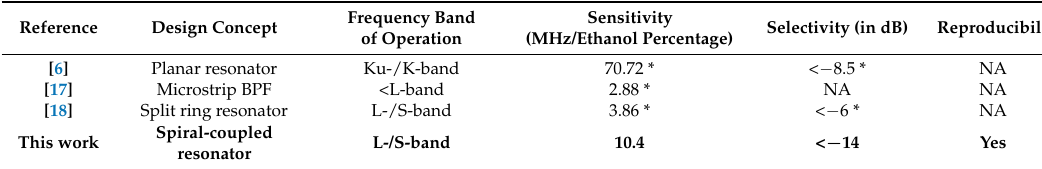
Table 1. Performance comparison of the proposed sensor with the